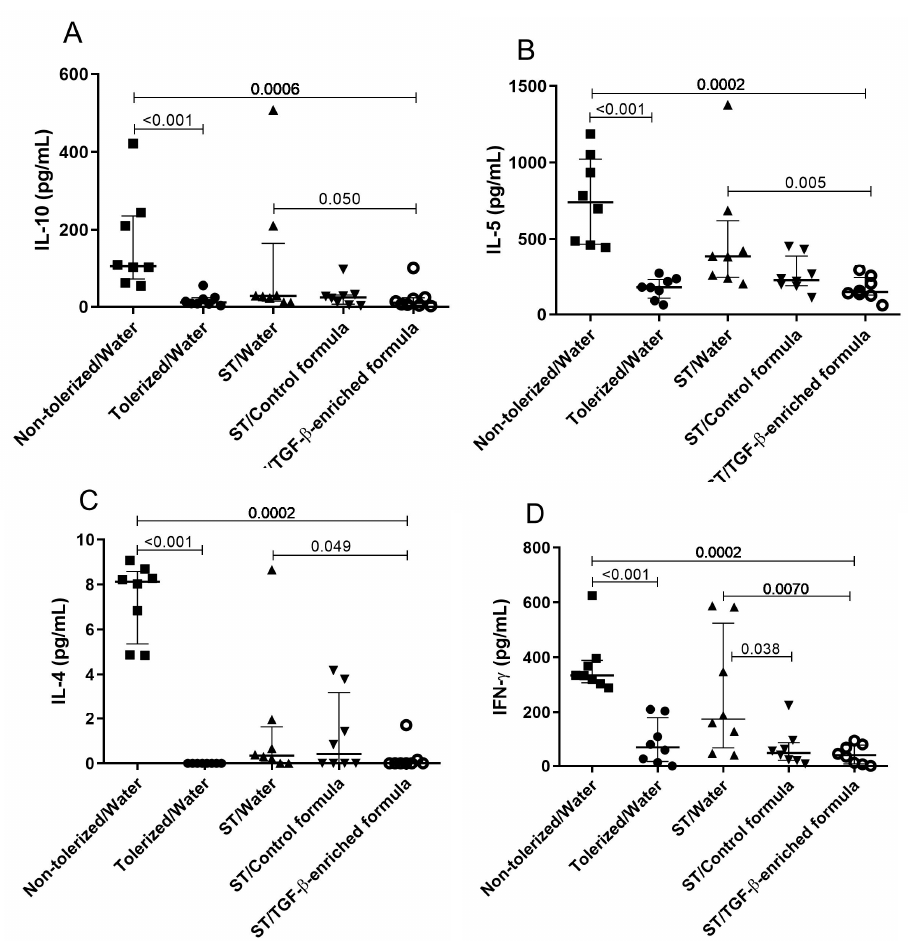
Figure 5. Effects of the TGF- β -enriched formula on cytokine expression in 5-week-old mice subjected to a food allergy protocol. Before sensitization, mice received PBS using gavage on days 6, 7, and 8 (non-tolerized/water), OVA (10 mg/mL) ad libitum from day 4 to day 8 (tolerized/water), or a sub-tolerogenic dose of OVA (0.5 mg) using gavage on days 6, 7, and 8 (ST/water). Suboptimally-tolerized mice had free access to either water (ST/water), control formula (ST/control formula), or TGF- β -enriched formula (ST/TGF- β -enriched formula) from day 1 to day 13. Lymph nodes were harvested from mice after euthanasia at day 35 and pooled by test group. After 72 h of cell culture with OVA (1 mg/mL), the amount of IL-10, IL-5, IL-4, and IFN- γ was determined in the culture supernatants. Results are representative of one experiment out of two. Values are expressed as median ± interquartile range of eight mice per group. Significant p -values ( ≤ 0.05) are shown on the graphs.